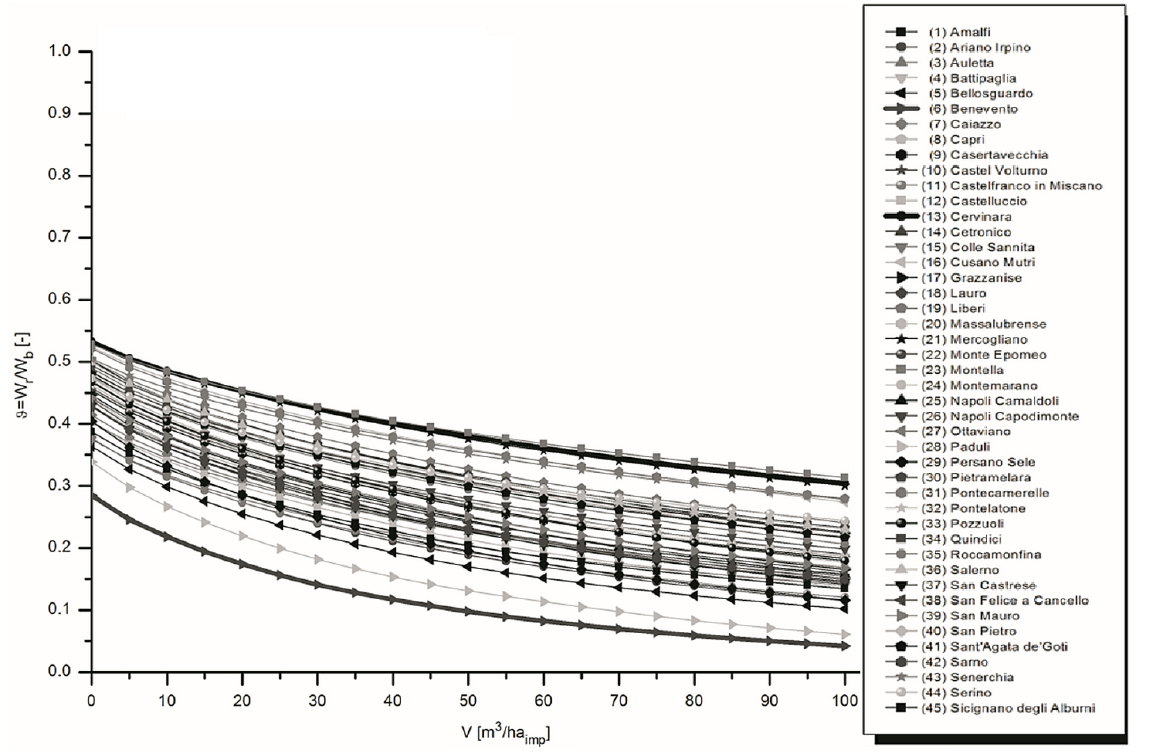
Figure 2. Volumes discharged into the receiver with varying useful tank storage. The characteristics of the two rain gauge stations considered are provided in Table 2.